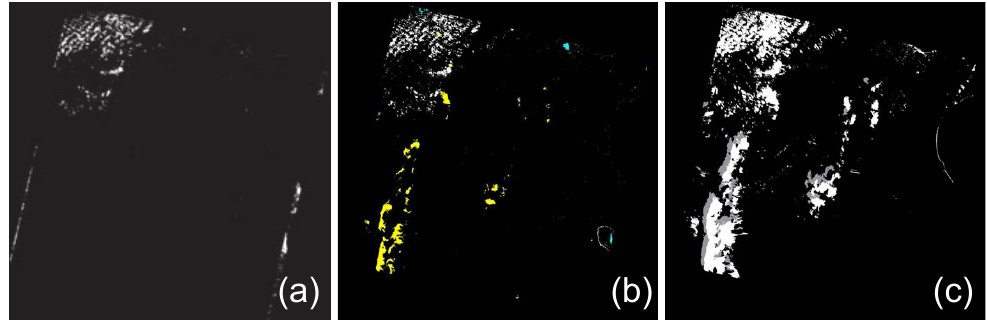
Figure A1. Comparing cloud detection methods on the Landsat 8 29 March 2013 image: (a) clouds detected over 1.7% of the image with the ACCA (Irish et al., 2006) and Goslee (2011) methods; (b) clouds including cirrus detected over 8.2% of the image with the Landsat 8 1380nm band; (c) clouds including cirrus and cloud shadows detected over 11.5% of the image with the Fmask (Zhu and Woodcock, 2014) method.